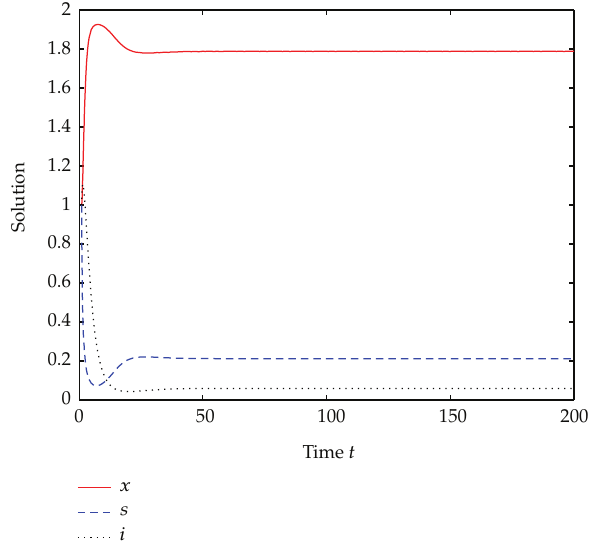
Figure 2: The temporal solution found by numerical integration of system (cid:4) 1.1 (cid:7) with r (cid:8) 2 , K (cid:8) 2 , a (cid:8) 1 , c (cid:8) 2 , β (cid:8) 2 , α (cid:8) 1 , d (cid:8) 0 . 4 , b (cid:8) 0 . 3 , τ (cid:8) 1, and (cid:4) x 0 ,S 0 ,I 0 (cid:7) (cid:8) (cid:4) 1 , 1 , 1 (cid:7)